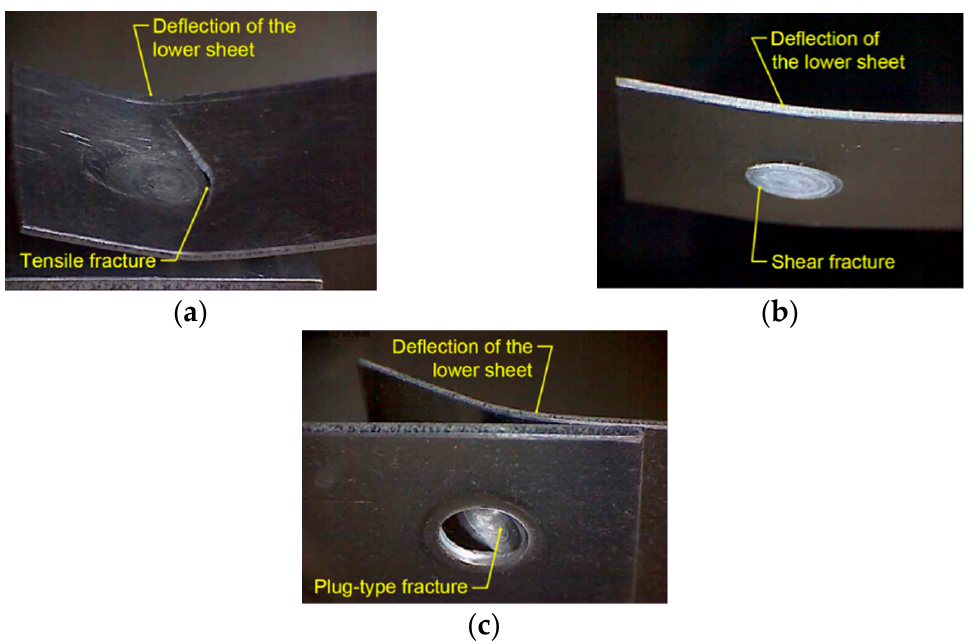
Figure 10. Modes of destruction of a joint subjected to a tensile shear test: ( a ) tensile fracture, ( b ) shear fracture and ( c ) plug-type fracture.